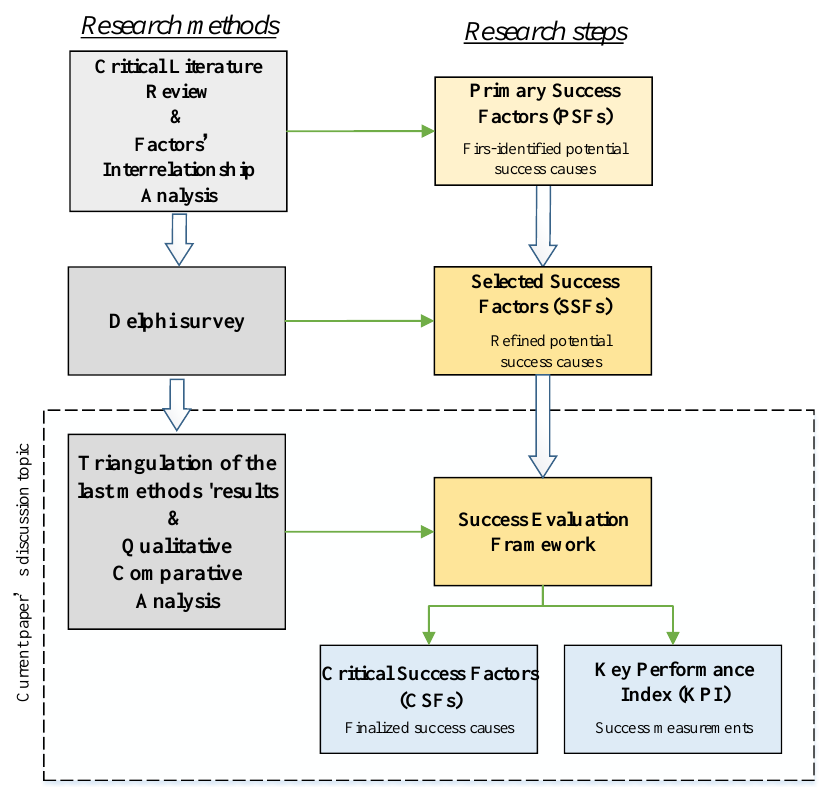
Figure 1. Research